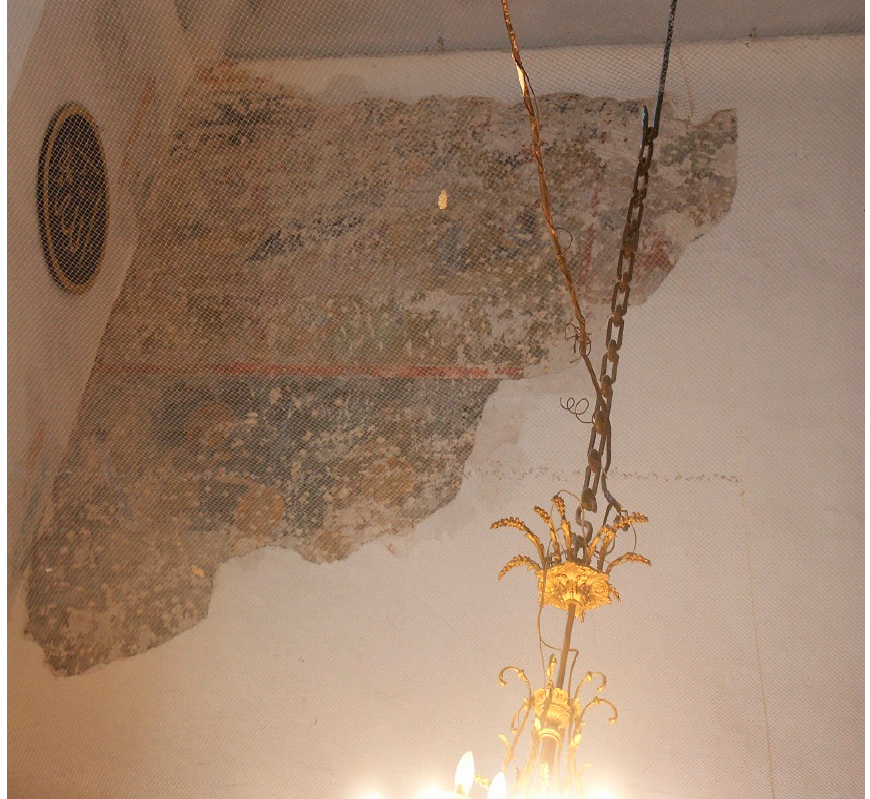
Figure 6. Pera, the church of St. Paul, south wall of the choir, scenes of Nativity and Baptism of Christ (mid-14th century?), fot. R. Quirini-Pop ł awski (2007).